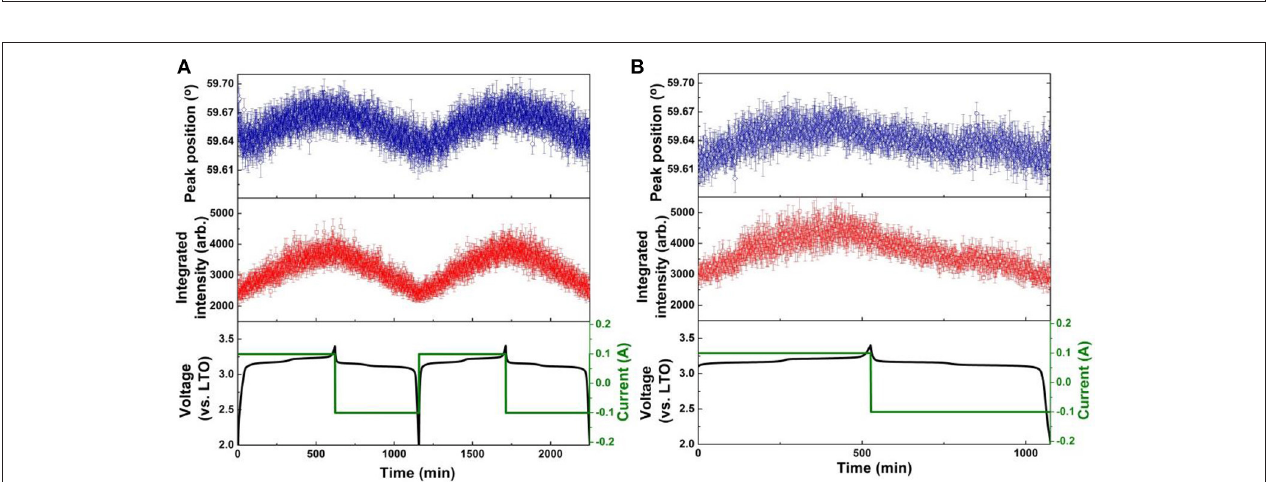
FIGURE 6 | Results of single peak fitting of the LTO 222 reflection in NPD data of the LNMO||AlF 3 -LTO battery, including peak position and intensity for (A) the first two cycles, and (B) the 51st cycle. Battery voltage and current are shown alongside.